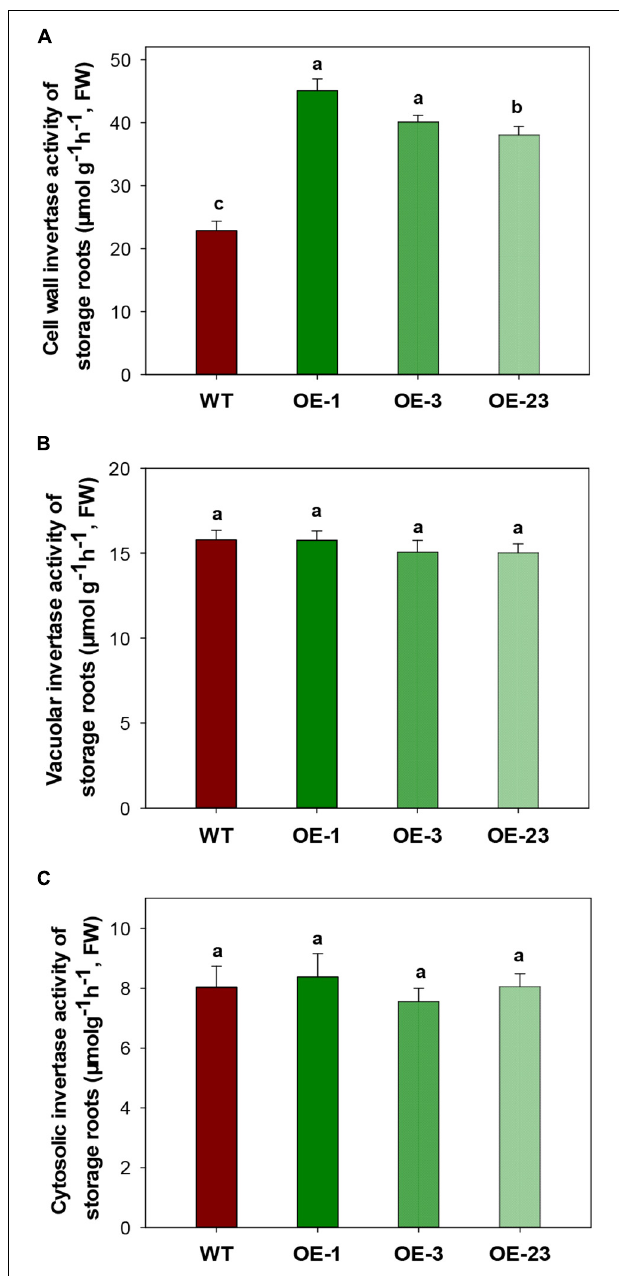
FIGURE 5 | INV activity assay in storage roots of wild-type (WT) and the MeCWINV3 -overexpressed (OE) cassava plants. (A) CWINV. (B) VINV. (C) CINV. Different letters indicate significant differences (one-way ANOVA, p < 0.05).